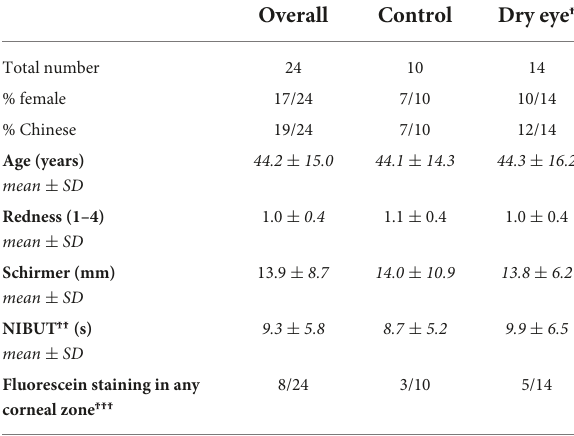
TABLE 1 Clinical and demographic characteristics of